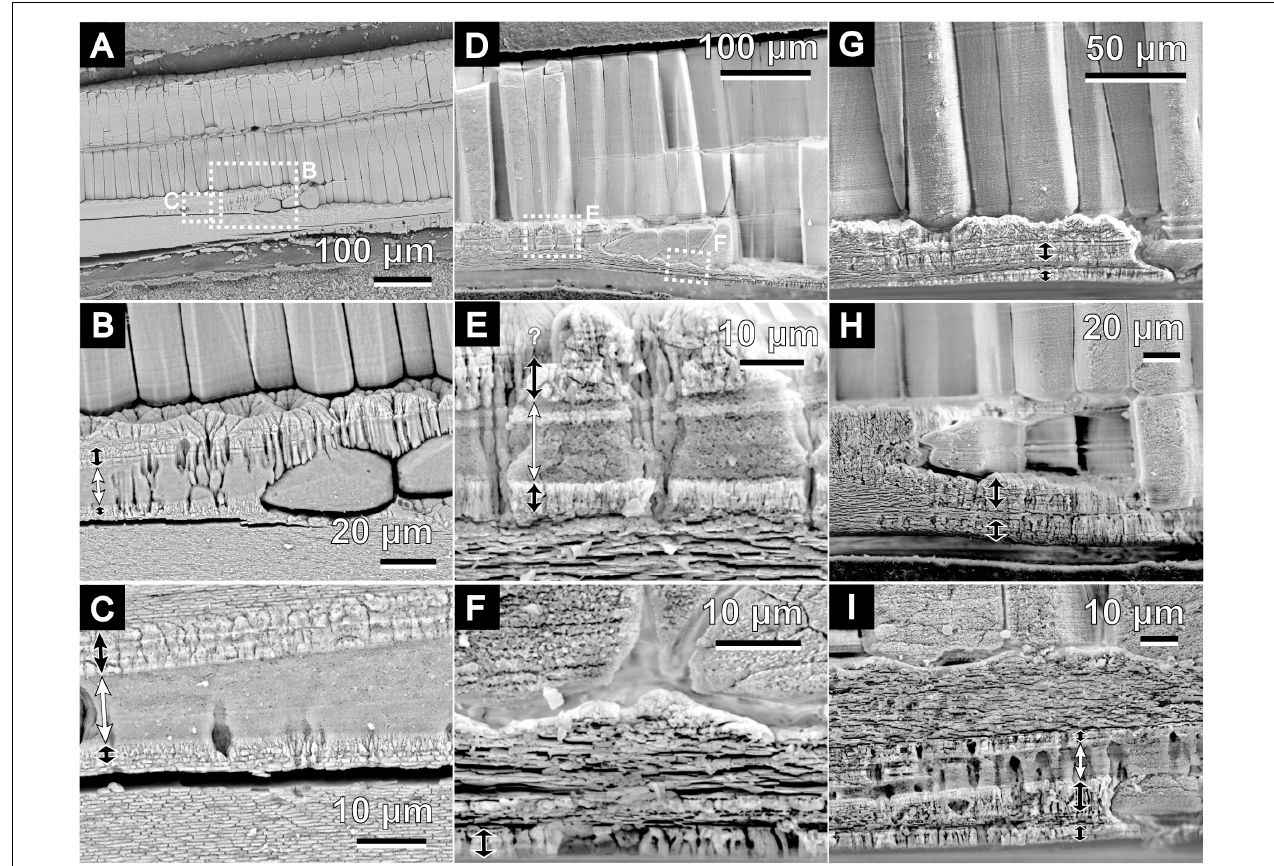
FIGURE 4 | Scanning electron micrographs of the microstructure of the irregular shell layer in P. fucata . All images show radial sections in polished planes. Growth direction of the shells are on the right side of images. White double-headed arrows indicate the middle sublayer of the irregular shell layer between the outer and middle layers. Black arrows show the distribution of the outer and inner sublayers. (A) Outer to middle shell layers of ID 180226-1, collected on February 26, 2018. Detailed views in panels (B,C) . (D) Outer to middle shell layers of ID 180404-4, collected on April 4, 2018. Detailed views in panels (E,F) . (G–I) Show the same structures as in panels (A,D) , but are of different individuals collected on April 4, 2018 [ID 180404-1 (G) , ID 180404-3 (H) , and ID 180404-2 (I)